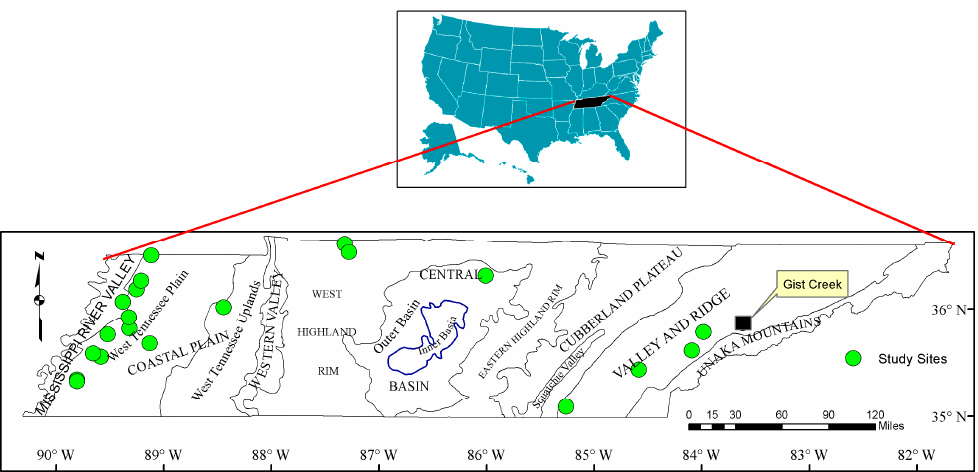
Figure 1. Study site locations using the mini ‐ jet test device in Tennessee, where Gist Creek is shown as a black square and the sites used for the multiple-pressure test among the different physiographic as a black square and the sites used for the multiple ‐ pressure test among the different physiographic provinces [43] are shown as green provinces [43] are shown as green circles.